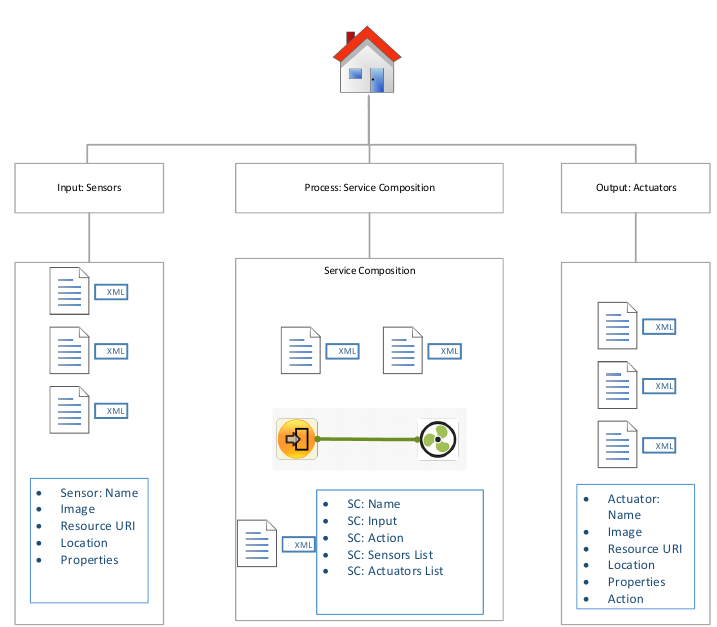
Figure 7. Cloud-based web application site map.